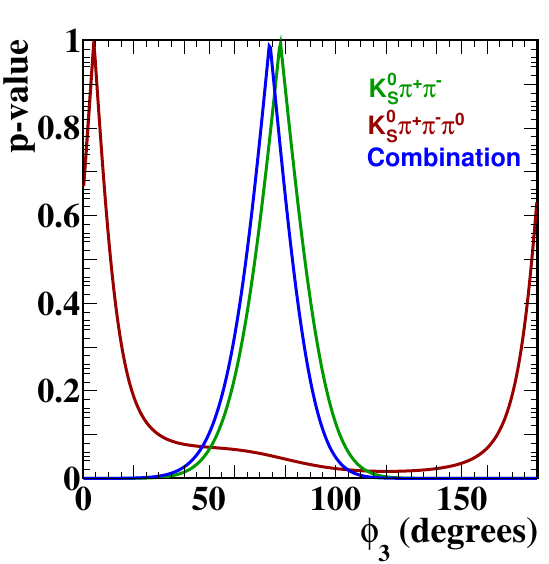
Figure 10 . Distribution of p-value for (cid:30) 3 from multibody D (cid:12)nal states at Belle, which is shown by the solid blue curve. The results from B ! DK ( (cid:3) ) decays with D ! K 0 (cid:25) + (cid:25) (cid:0) are shown by the S solid green curve and the D ! K 0 (cid:25) + (cid:25) (cid:0) (cid:25) 0 (cid:12)nal states are shown by the solid brown curve [11, 38]. S